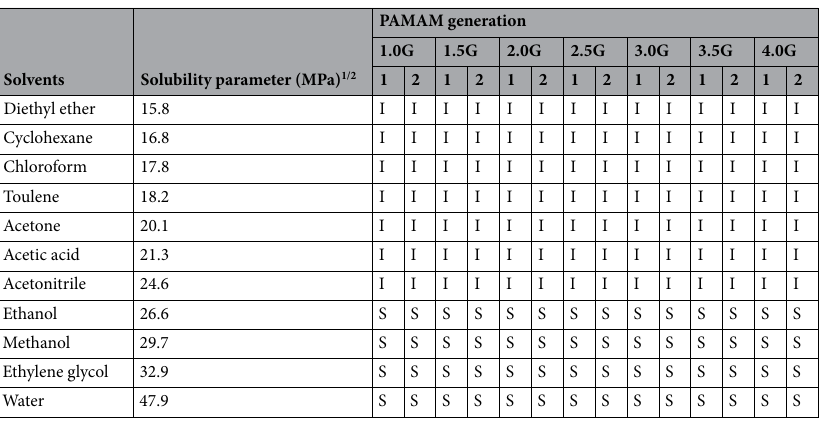
Solvents Solubility parameter (MPa) 1/2